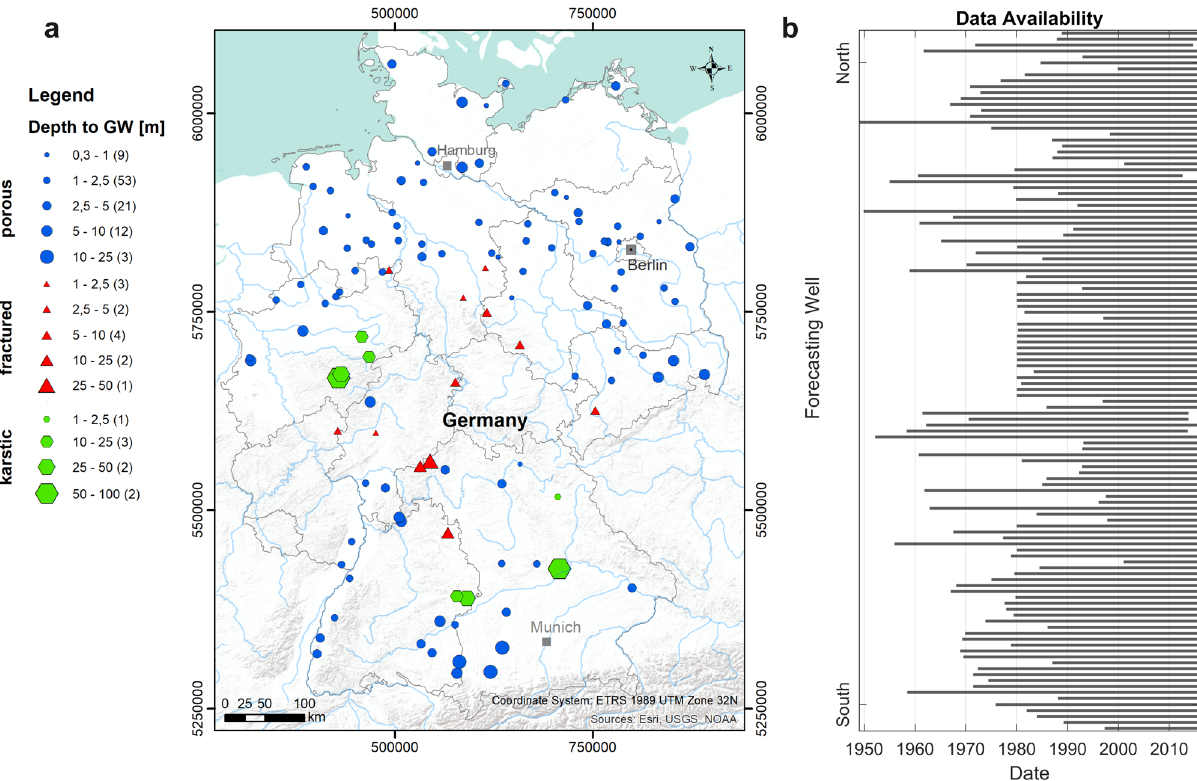
Fig. 6 Overview map and data availability. a Position, type of aquifer, and depth to groundwater for each study site. b Time series length of all study sites ordered in North – South